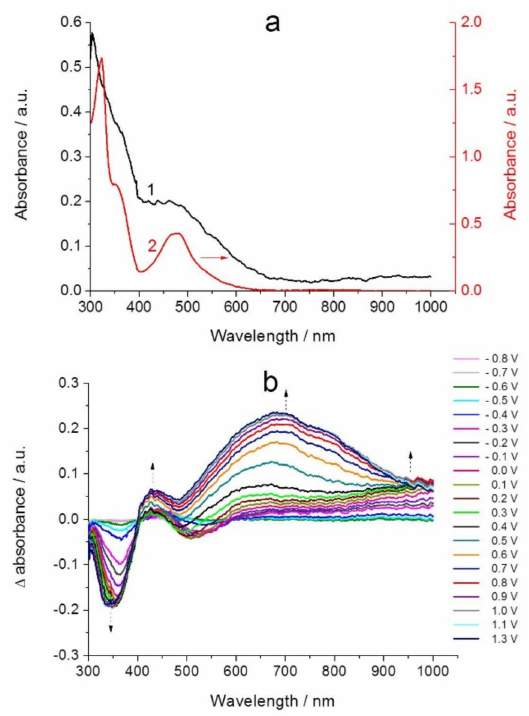
Figure 9. UV-Vis spectra of a poly-[NiAmben]-modified ITO-coated glass electrode in 0.05 M Et 4 NBF 4 /DCE in the potential range from − 0.9 to 1.3 V: ( a ) the spectrum of the polymer at − 0.9 V (black curve 1) and the spectrum of [NiAmben] monomer (red curve 2); ( b ) differential spectra, referenced to the spectrum of the polymer at − 0.9